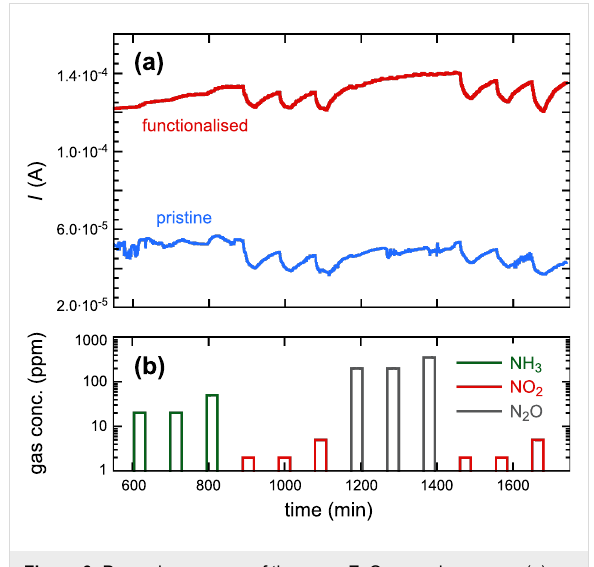
Figure 6: Dynamic response of the same ZnO nanowire sensor, (a) before and after THMA functionalization and (b) during exposure to different concentrations of NH 3 , N 2 O and NO 2